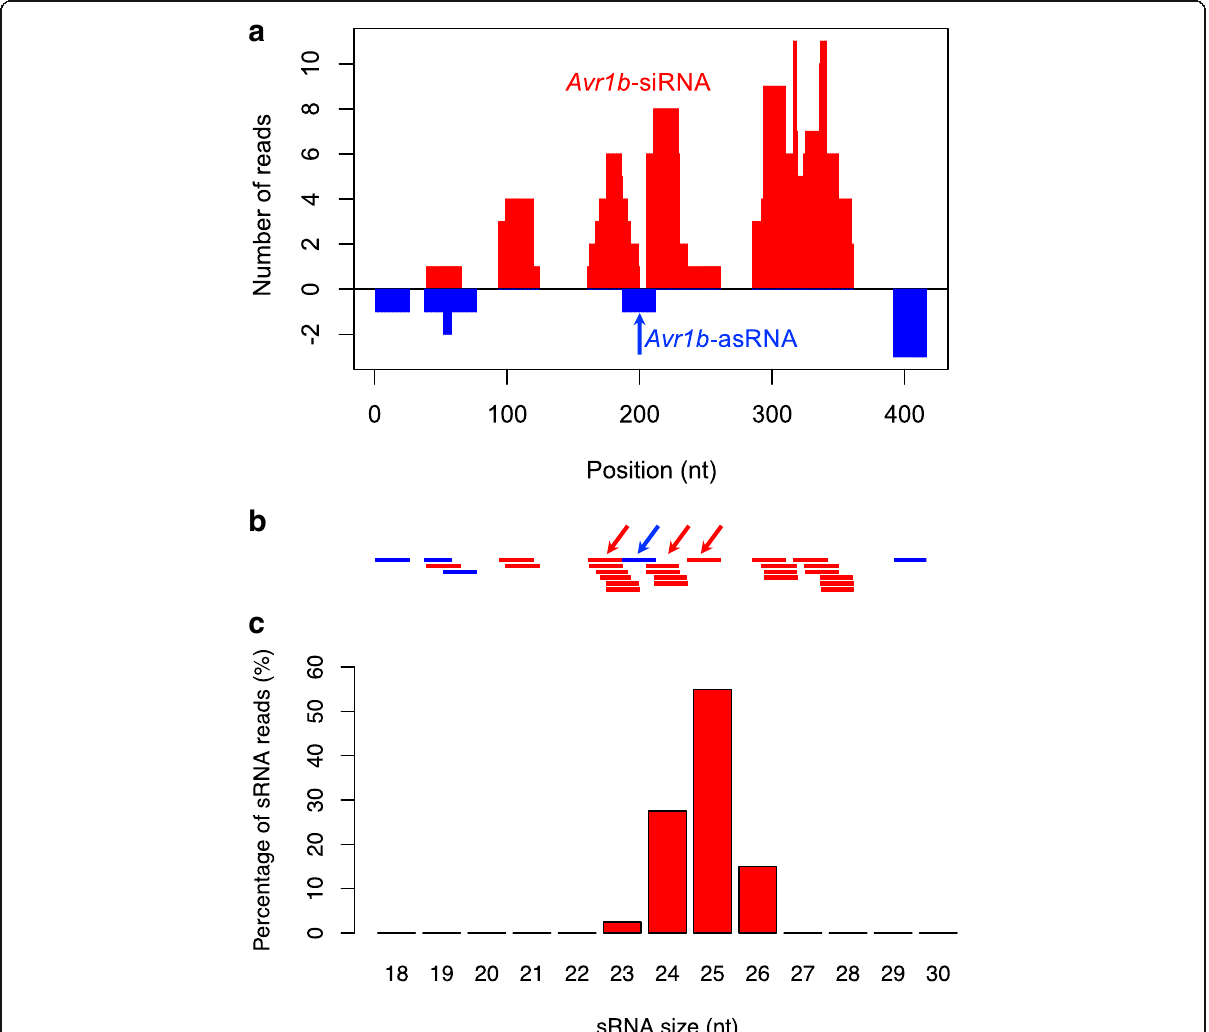
Fig. 1 Identification of P. sojae Avr1b sRNAs. a The abundance distribution of Avr1b sRNA reads homologous to the ORF region. The sense sRNA reads (above the x-axis) are highlighted in red, and the antisense sRNA reads (below the x-axis) are highlighted in blue. b The position distribution of Avr1b reads homologous to the ORF region. The red arrows indicate Avr1b -siRNA molecules, and the blue arrow that spans two red reads is Avr1b -asRNA. The sRNA reads and reference gene sequences are all from P. sojae strain P6497. The position and length of sRNA reads are drawn in scale. c The size distribution of Avr1b